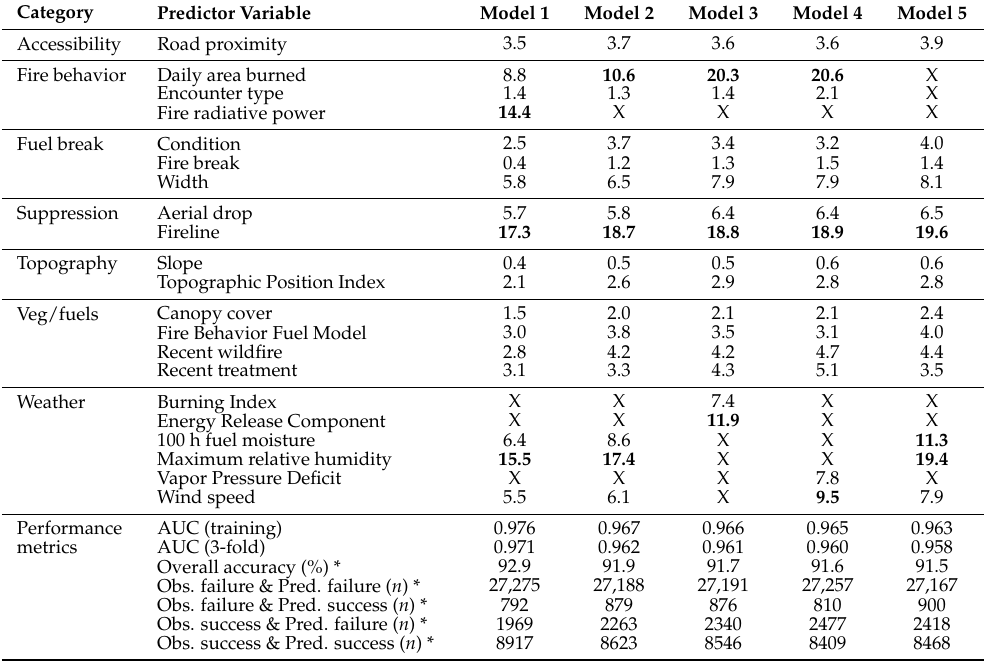
Table 3. Relative variable importance by model for included variables (top). The three most important variables in each model are in bold. Excluded variables are marked with X. Model performance metrics (bottom). * denotes accuracy metrics based on success predicted for probabilities ≥ 0.5 with the full model training